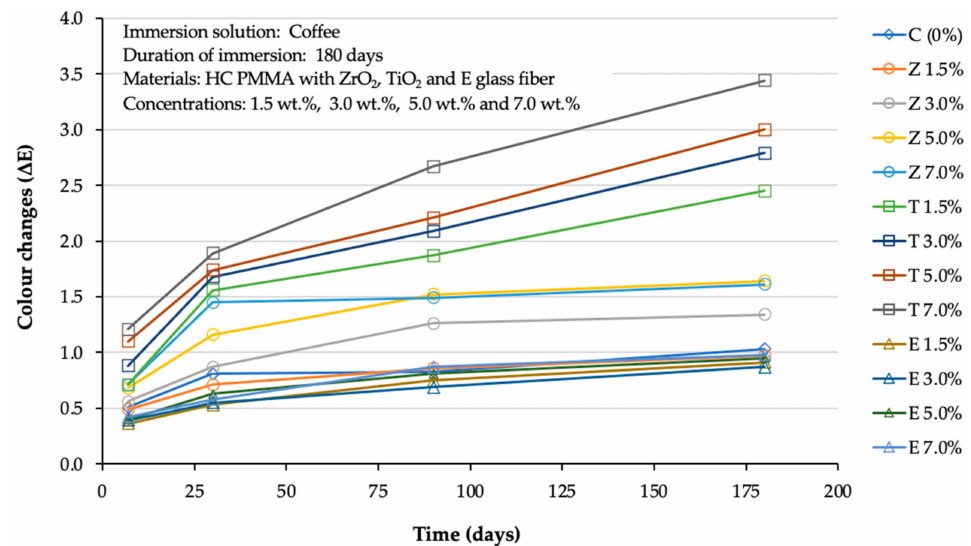
Figure 2. Line graph showing the cubic trend of the studied materials across the different time points in coffee solution.